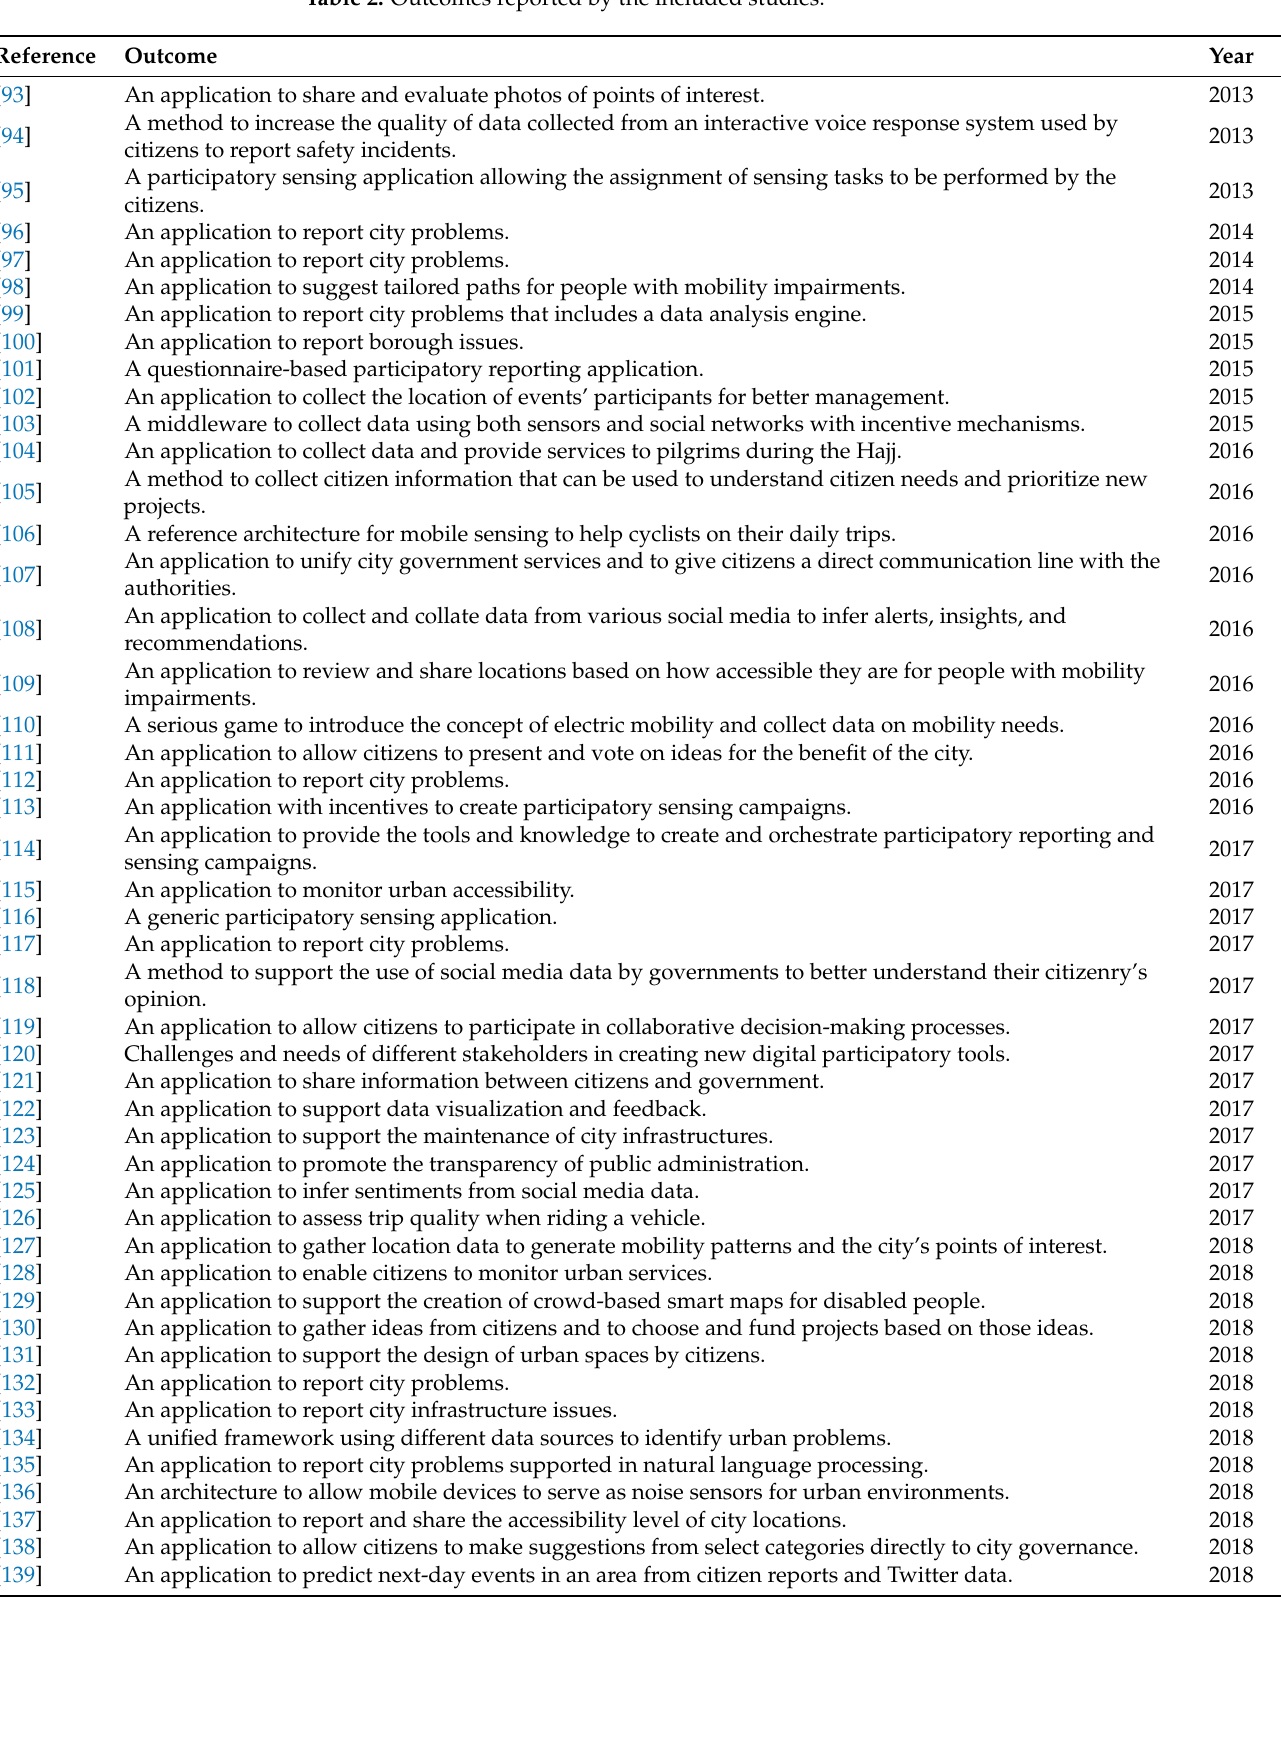
Table 2. Outcomes reported by the included